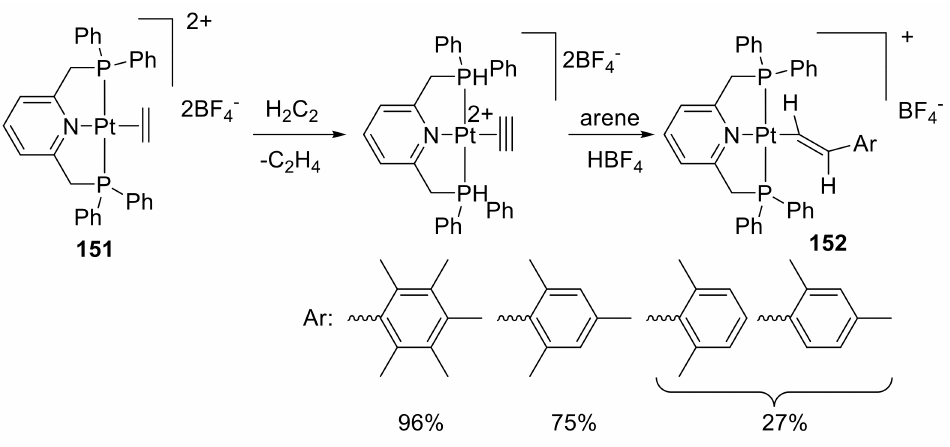
Scheme 79. Pt-catalyzed selective hydroarylation.